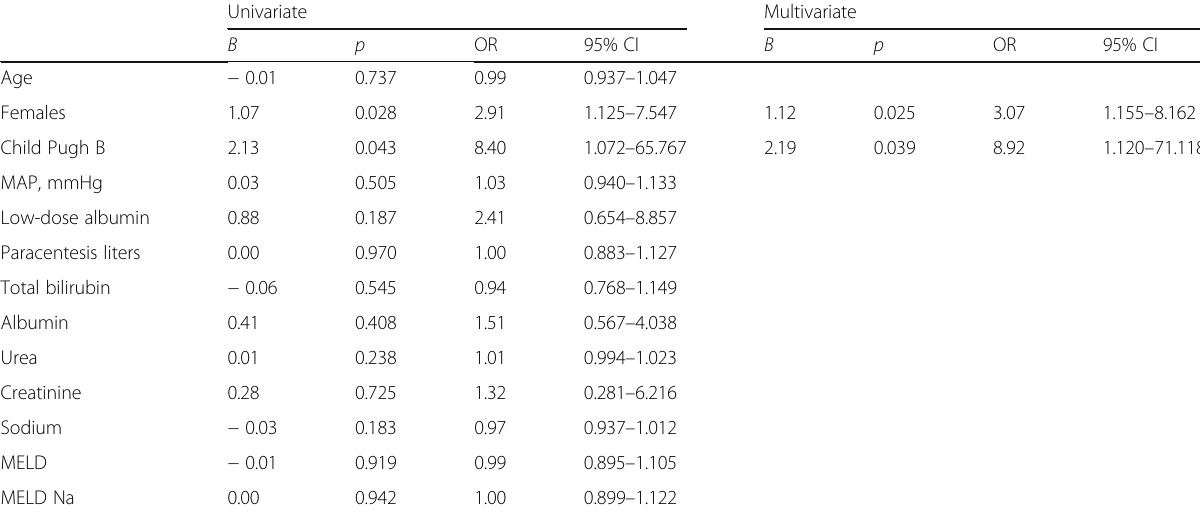
Table 3 Univariate and multivariate analysis of predictors of PICD occurrence Univariate Multivariate